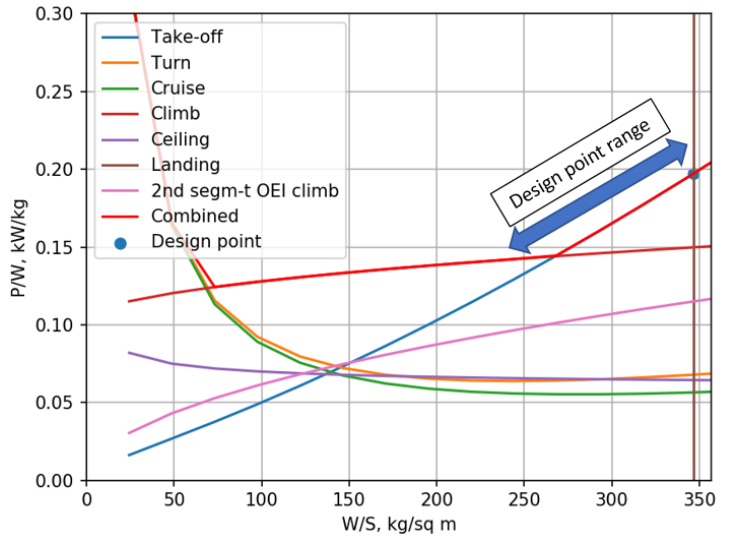
Figure 10. A sample constraint diagram and the range of possible design point or the initial